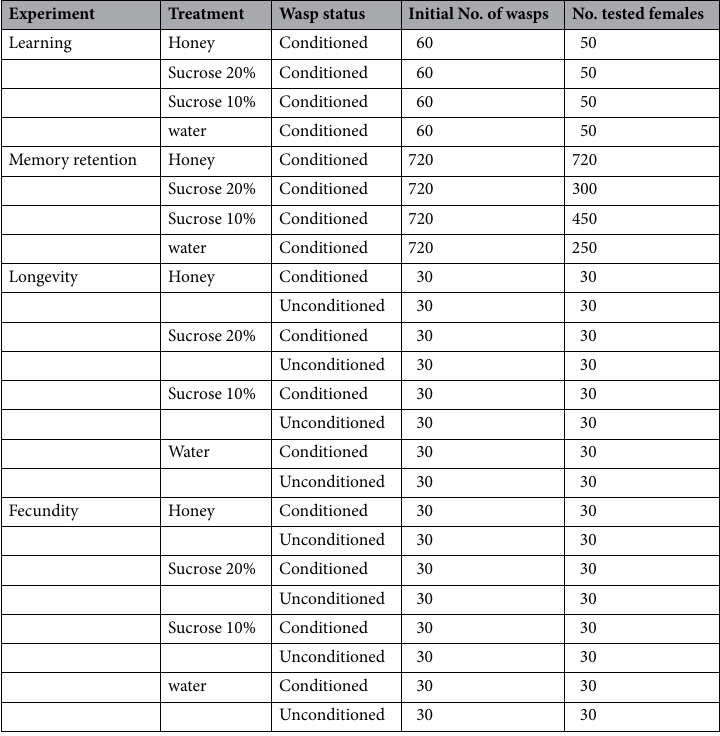
Table 1. The numbers of wasps used and actually tested for each